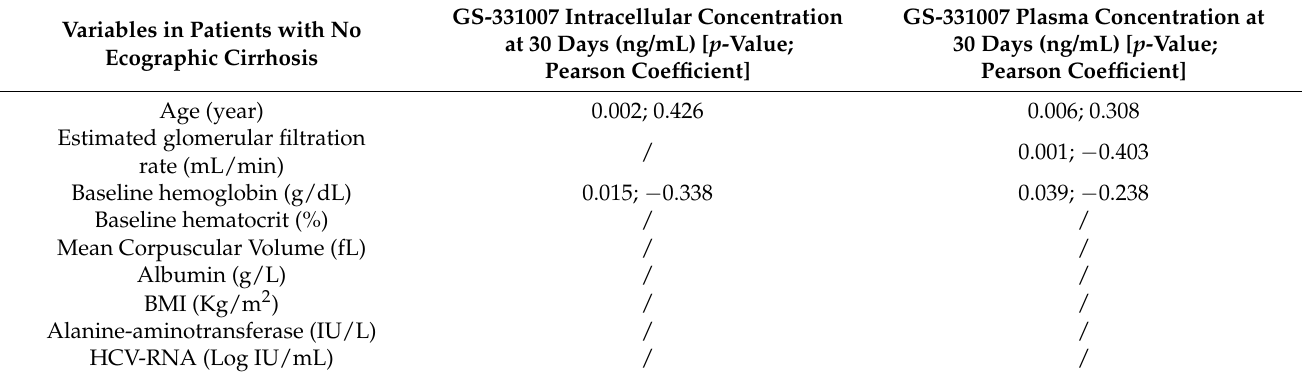
Table 4. Associations of GS-331007 IC and plasma levels with demographic and hematochemical parameters in patients with no ecographic